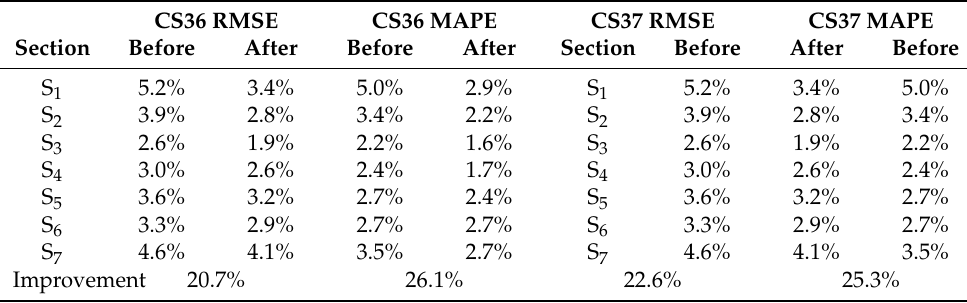
Table 5. Comparison of capacity estimation before and after BCT (CALCE